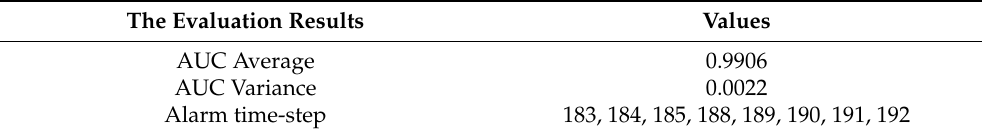
Table 4. M-iForest model evaluation results and malfunction alarm time-step without prediction by